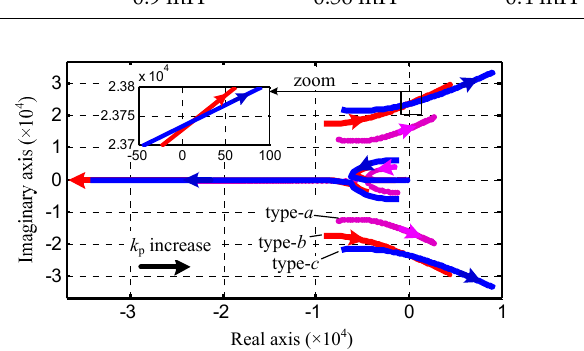
Figure 7. Root loci of the three types of inverters.